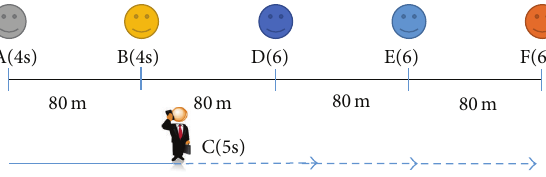
Figure 8: Moving node pattern experiment